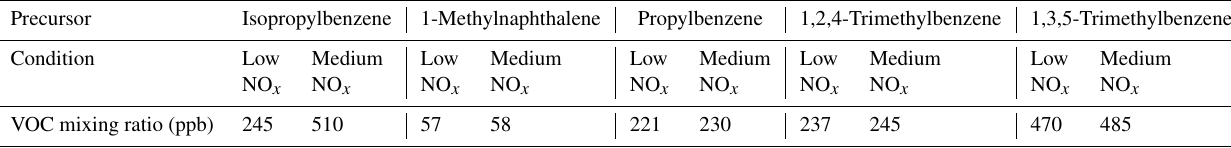
Table 1. VOC concentrations during single experiments for each precursor. Note: ppb – parts per billion. Precursor Isopropylbenzene 1-Methylnaphthalene Propylbenzene 1,2,4-Trimethylbenzene 1,3,5-Trimethylbenzene Condition Low Medium Low Medium Low Medium Low Medium Low Medium NO x NO x NO x NO x NO x VOC mixing ratio (ppb)